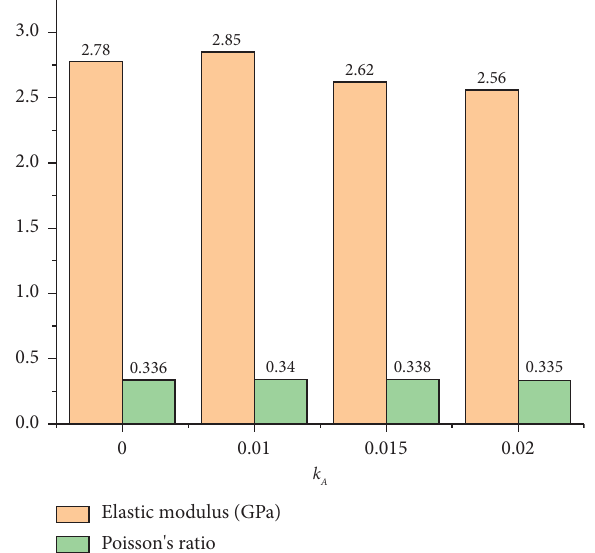
Figure 22: Elastic modulus and Poisson’s ratio of stones with diferent k